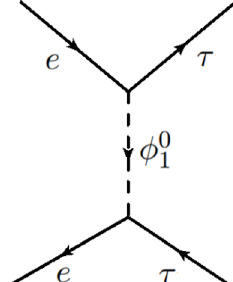
Figure 9 . Feynman diagram contributing to the process e (cid:0) e + ! (cid:28) (cid:0) (cid:28) + process in the SU(2) H